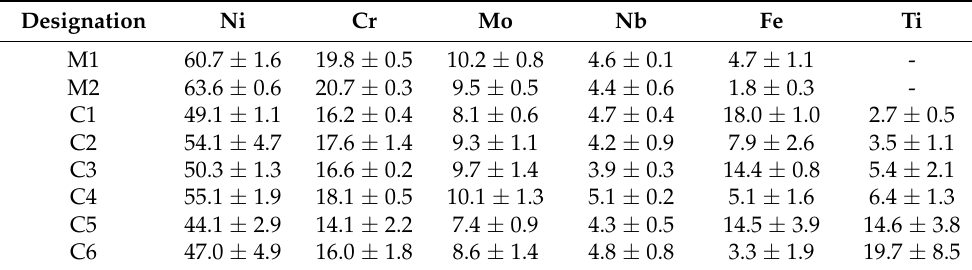
Table 5. Average chemical composition of the coatings, designations in accordance with Table